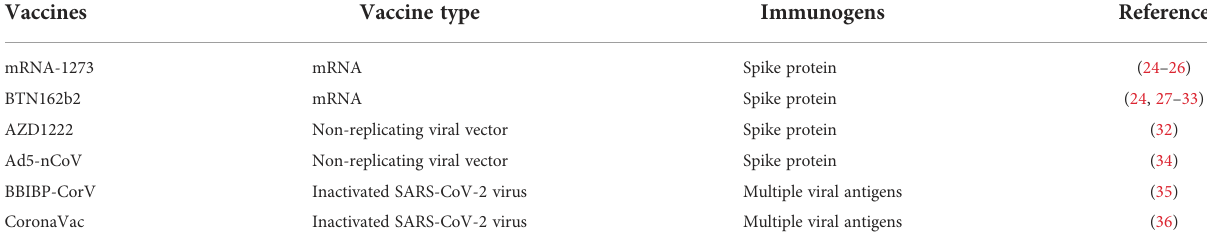
TABLE 1 The approved COVID-19 vaccines explored by single-cell technologies.